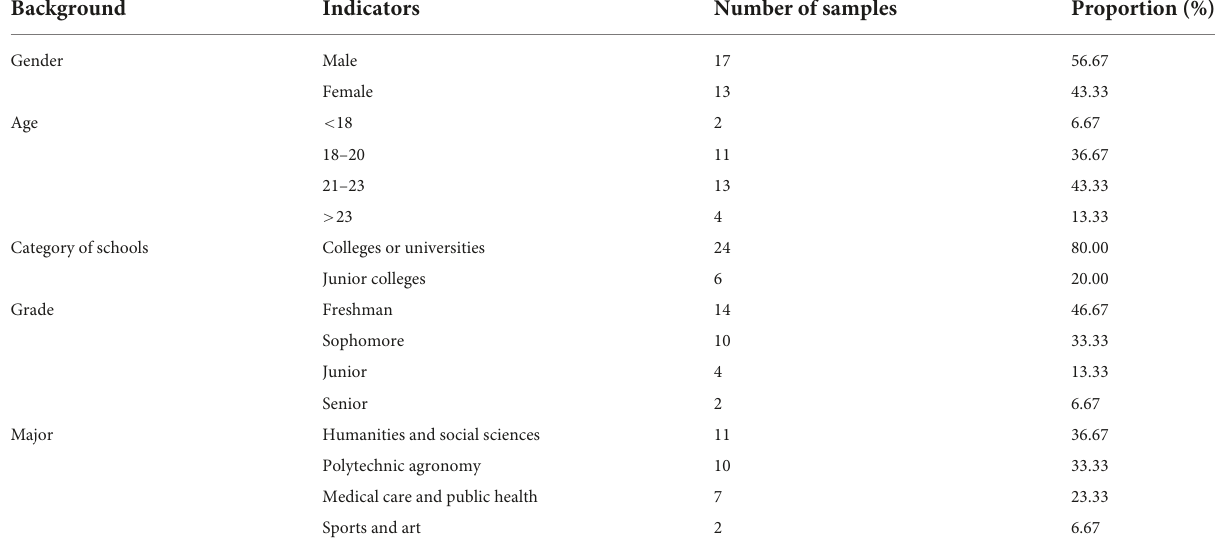
TABLE 2 Statistics of